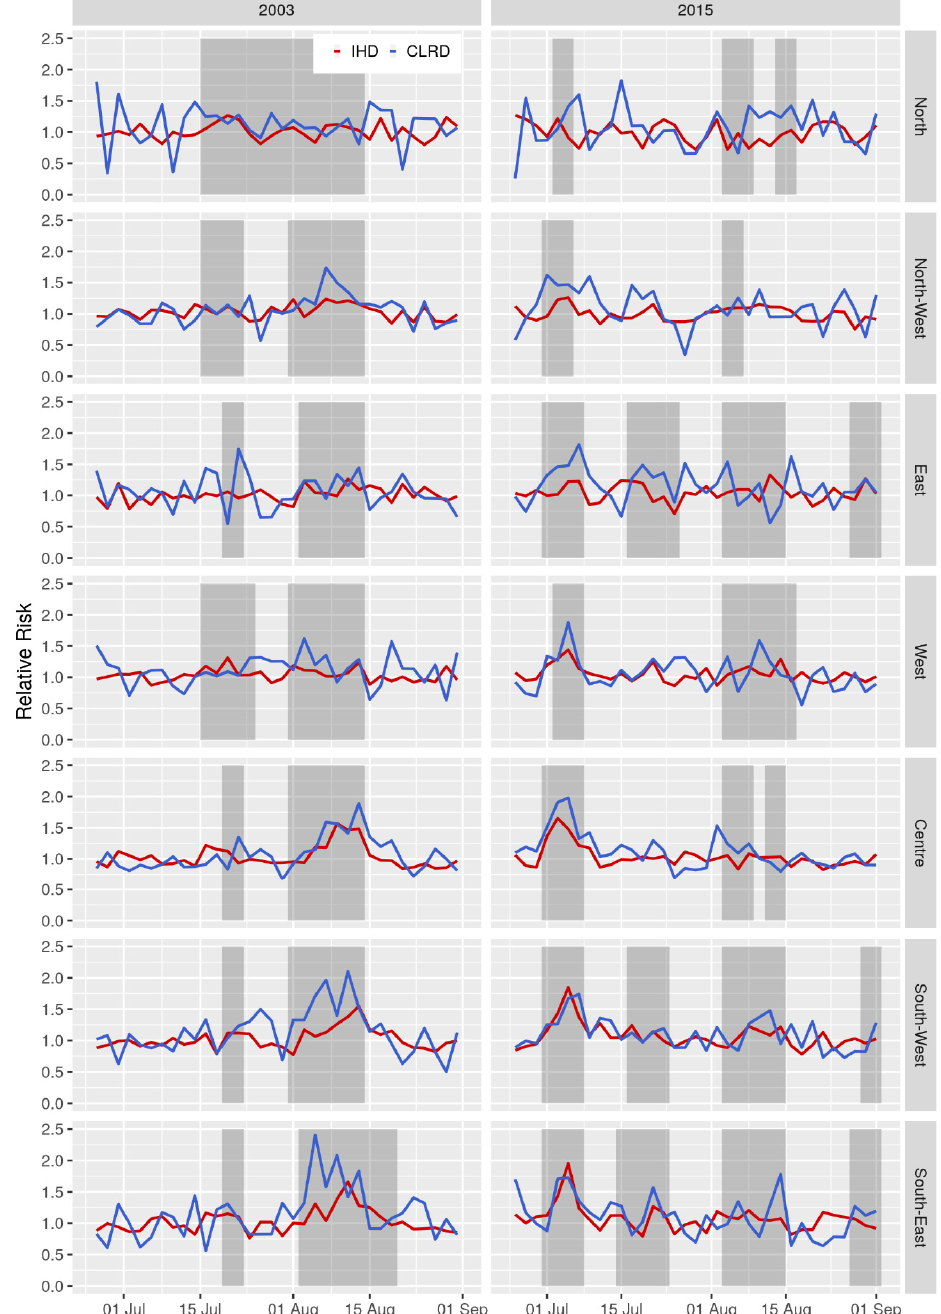
Figure 8. Relative Risk of CLRD and IHR mortality during heat waves (grey columns highlight the heat wave days) for summer 2003 (left) and summer 2015 (right), in seven regions in Germany (for regions see Figure 1).